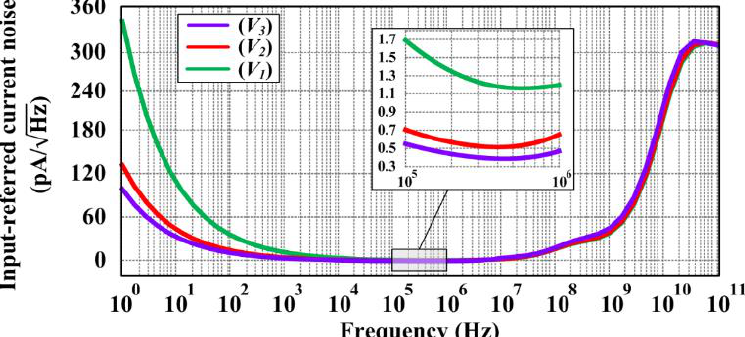
Figure 6. Input-referred noise current for the three transimpedance gains activated by the control voltages V 1 , V 2 , V 3 . In the inset, the magnification in the reduce range of frequencies from 100 kHz to 1 MHz.